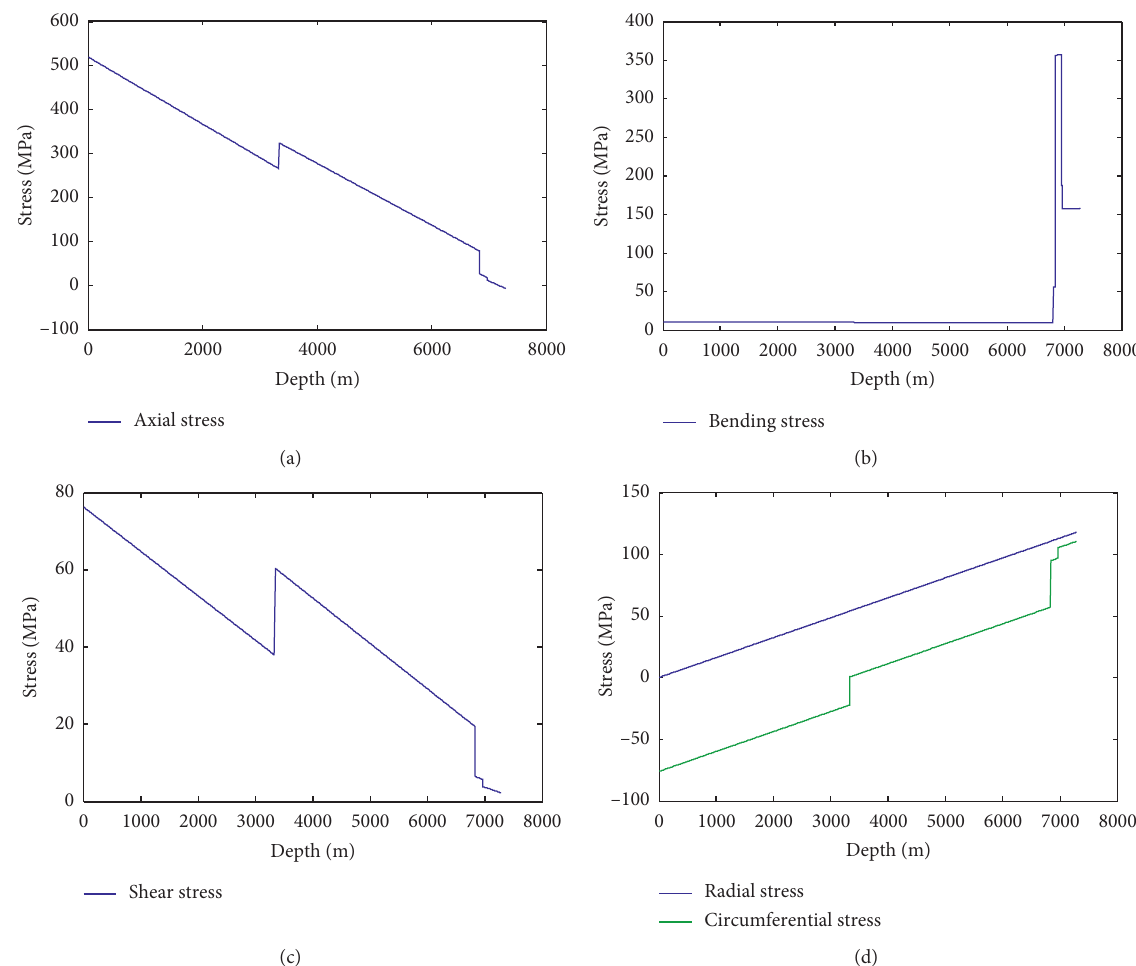
Figure 9: Schematic diagram of stress changing with distance from section to wellhead. (a) Change of axial stress. (b) Change of bending stress. (c) Change of shear stress. (d) Change of circumferential stress and radial